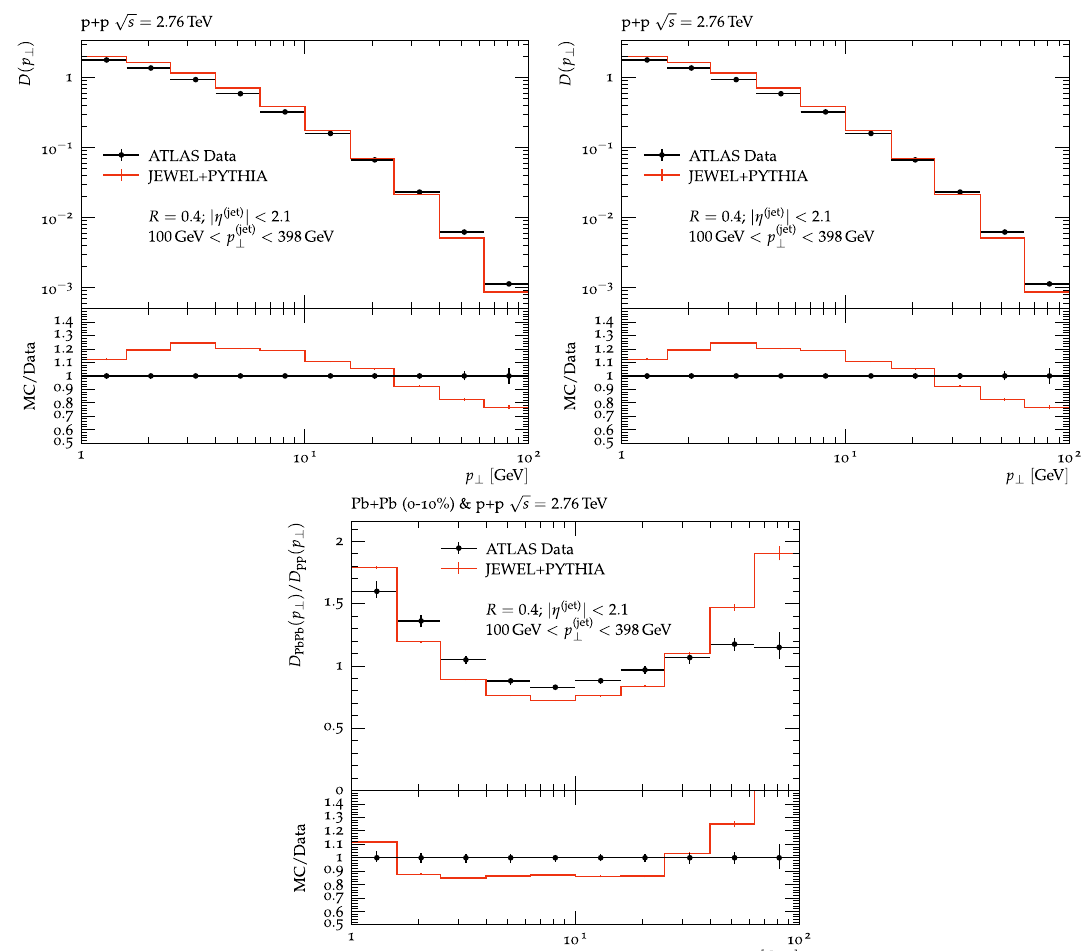
Fig. 10 Jet fragmentation function for charged particles as a func- and | η ( jet ) | < 2 . 1 in p+p and Pb+Pb (0 − 10% centrality) collisions. √ s NN = 2 . 76 TeV measured by ATLAS [82] tion of particle p ⊥ at JEWEL+PYTHIA results are shown with constituent subtraction for ( jet ) charged < 398 GeV for R = 0 . 4 anti- k ⊥ jets with 100 GeV < p ⊥